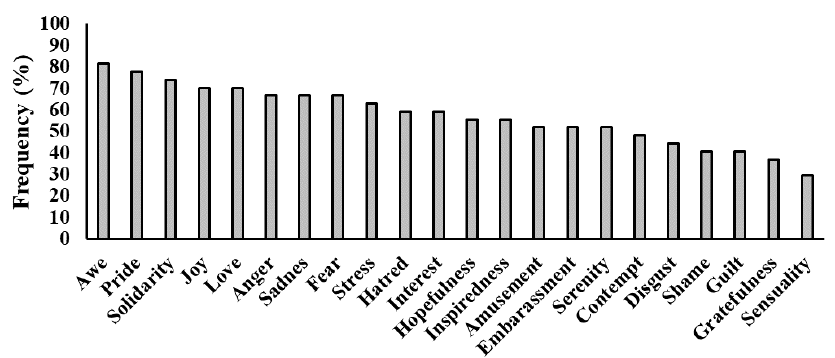
Figure 4. Proportion of Poor Sleepers reporting each of the 22 emotions during the dream.